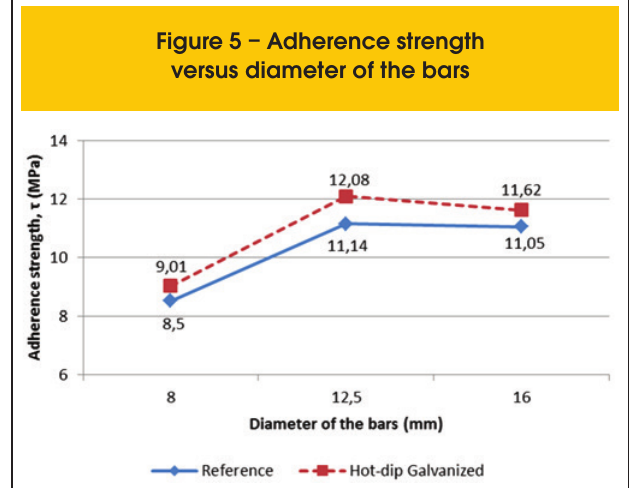
Figure 5 – Adherence strength versus diameter of the